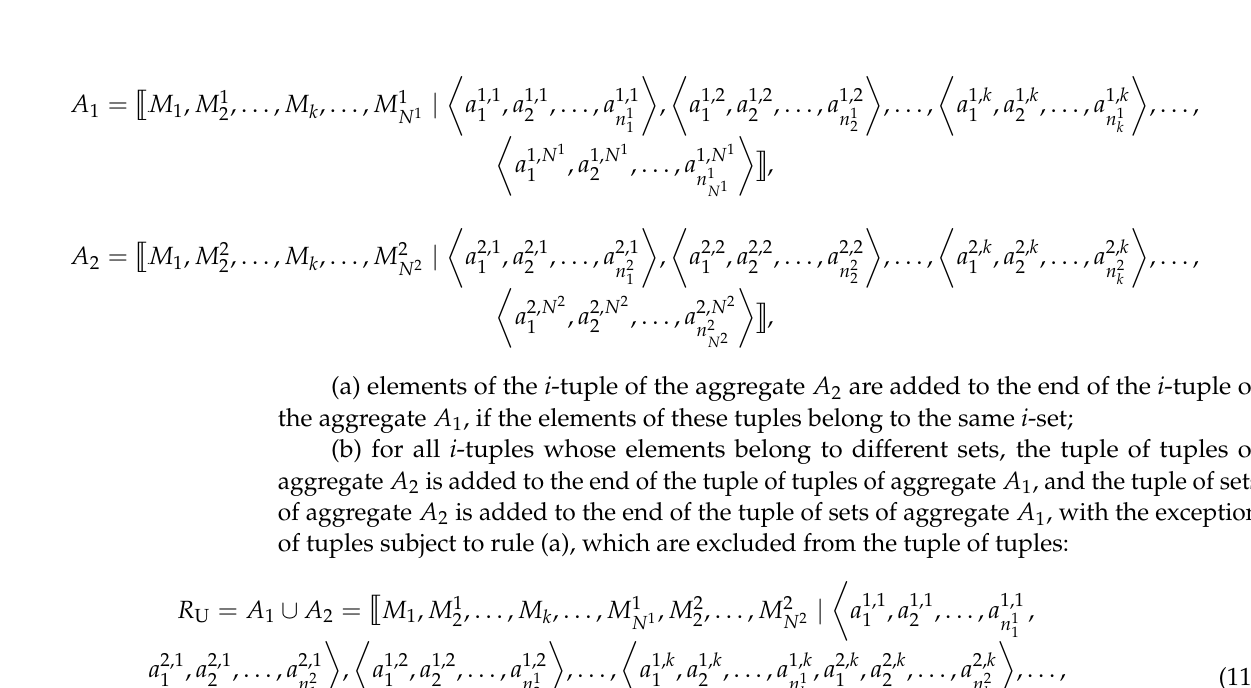
Figure 1. An example of two compatible aggregates. Figure 3. An example of two incompatible aggregates.